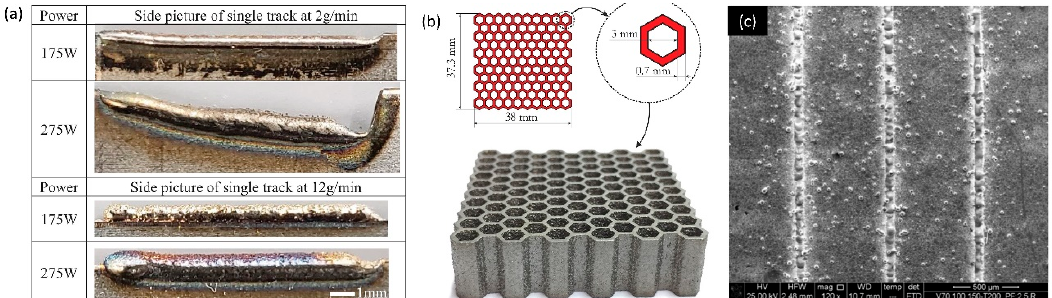
Figure 5. Example of PDED/DLMD 3D-printed parts. ( a ) Single track material deposition by PDED 3D-printing process. Reproduced with permission from [139]; ( b ) laser engineered net shaping (LENS) 3D-printed cellular honeycomb structures. Reproduced with permission from [140]; ( c ) NiTi single tracks printed by PDED 3D-printing process. Reproduced with permission from [144].